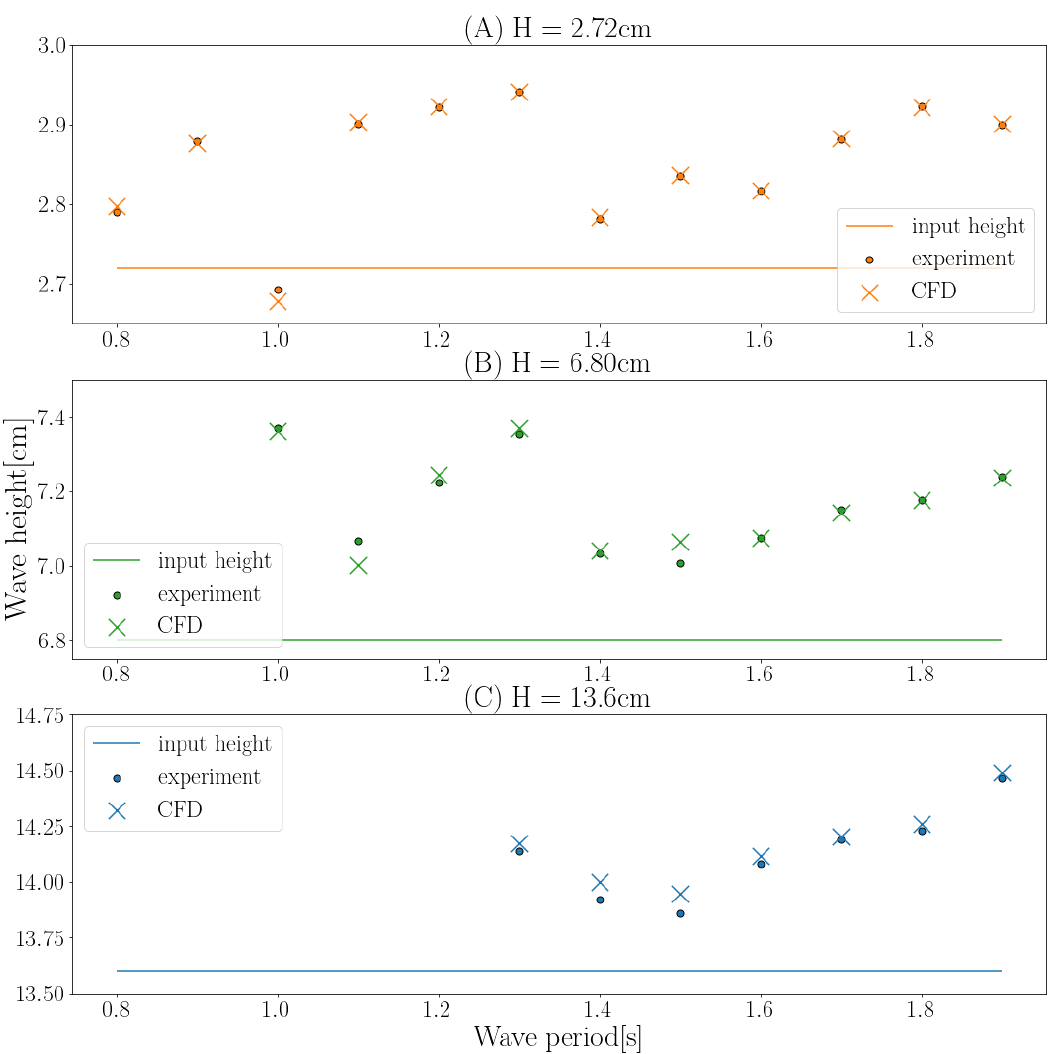
Figure 10. Wave height obtained from RMS of the time series.